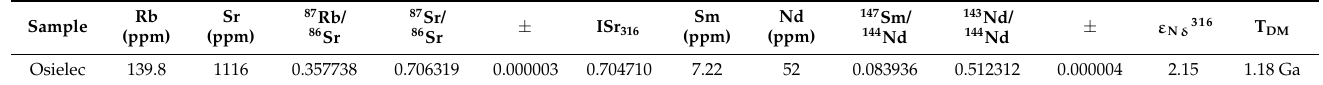
Table 6. Sm-Nd and Rb-Sr whole-rock isotopic data from the exotic crystalline block from Oseilec.